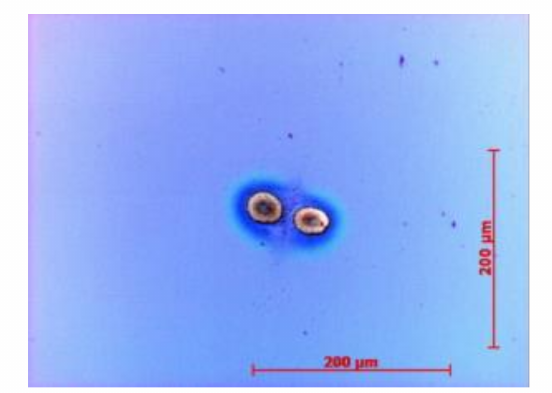
Figure 10. Example of 200 × Nomarski micrograph of a damaged site (energy density 3.4 J/cm 2 , damage after 137 pulses) for sample